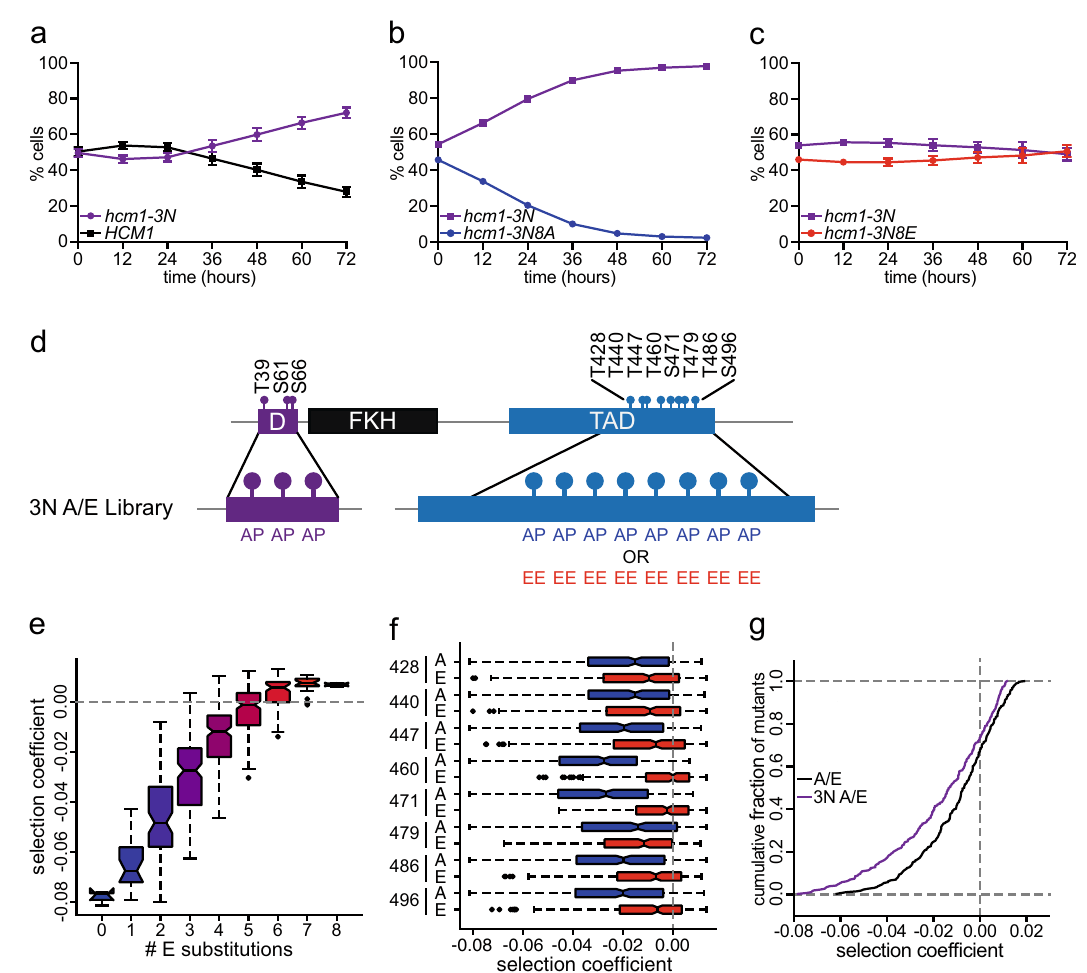
Fig. 4 | Stabilization of Hcm1 partially mitigates the effects of TAD phosphor- ylation. a – c Strains expressing the indicated HCM1 alleles from plasmids were co- cultured and the percentage of cells expressing each allele was determined at the timepoints indicated. In total, 5000 cells were analyzed from each timepoint. Shownisanaverageof n =3experiments,errorbarsrepresentstandarddeviations. Black represents cells expressing WT HCM1 ( a ), purple represents cells expressing hcm1-3N ( a – c ),blue represents cellsexpressing hcm1-3N8A ( b ),and red represents cells expressing hcm1-3N8E ( c ). d Schematic showing the design of the 3N A/E phosphomutant library. D indicates the phosphodegron consisting of three S/T-P sitesthathavebeenmutatedtoA-P(3N).TheeightS/T-PsitesintheTADhavebeen mutated to either A-P or E-E in all 256 possible combinations. e , f Box and whisker plots showing the median selection coef fi cients of groups of mutants with the indicated number of phosphomimetic mutations ( e ),or with speci fi c substitutions at the indicated positions ( f ). Color gradient from blue ( hcm1-3N8A ) to red ( hcm1-